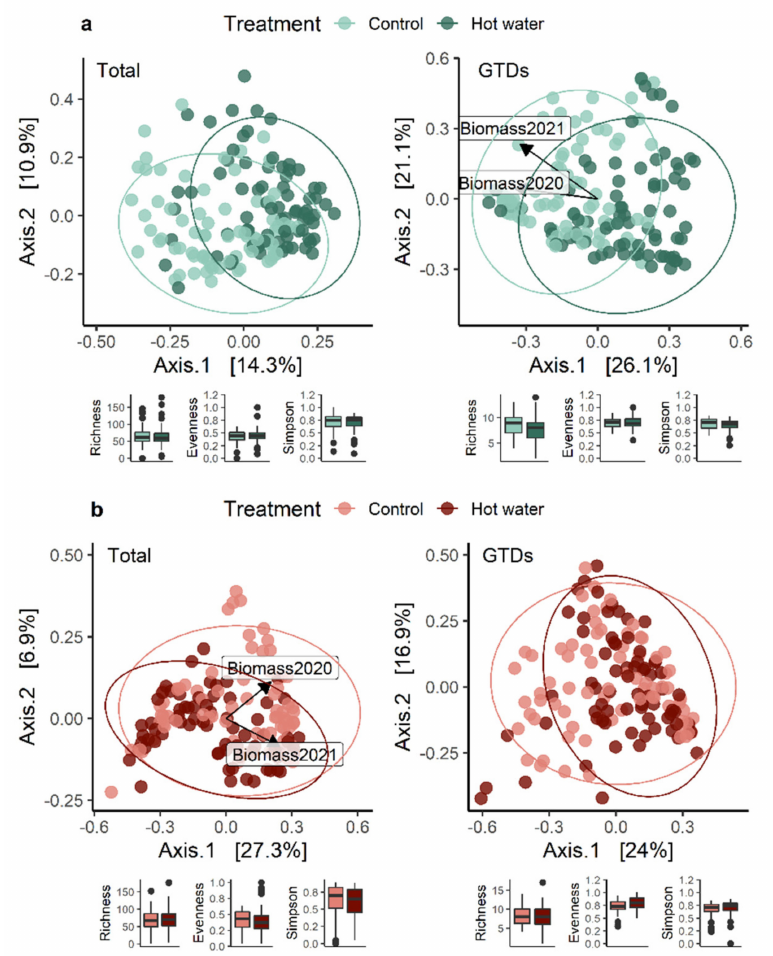
Figure 4. PCoA ordinations calculated with a Bray-distance matrix showing tissue-specific fungal community structures by treatment in ( a ) graft unions and ( b ) root collars. Vectors indicate biomass accumulation for the whole plant in 2020 and 2021. The R 2 and p -values shown are extracted from a PERMANOVA analysis performed with the adonis2 function in R, in which all design variables are included. Alpha diversity indices (species richness, evenness, and Simpson diversity index) are presented below each